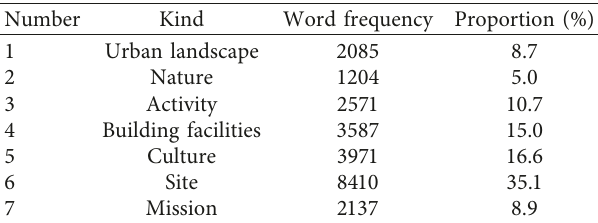
Table 4: Overall image ratio of inbound tourists in